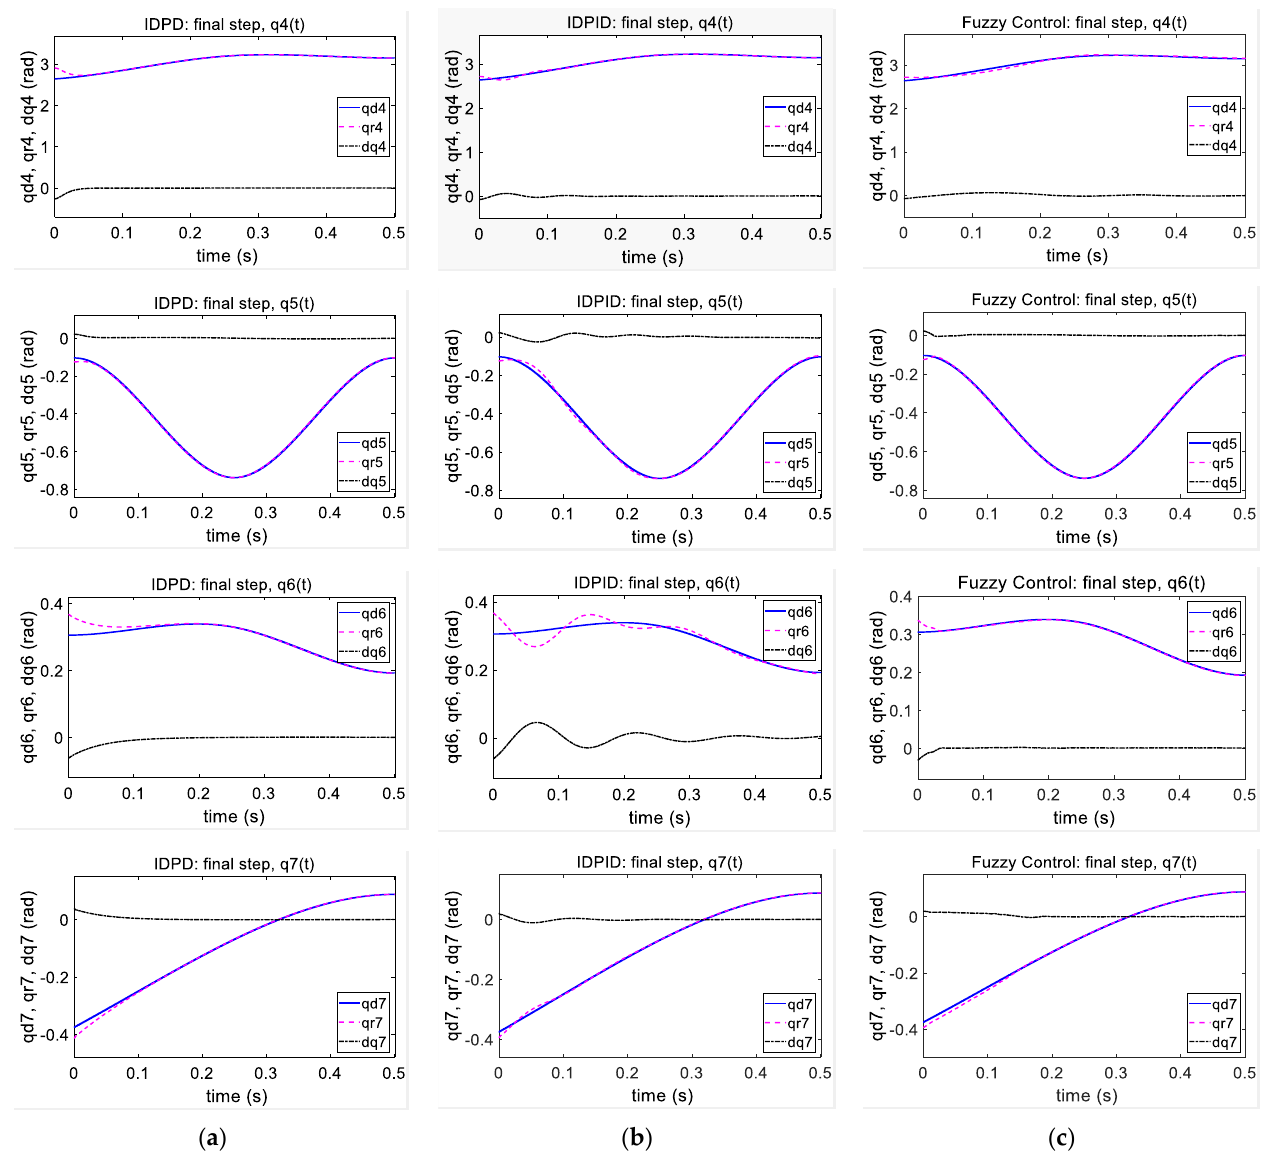
Figure 17. Simulation results of controllers for bipedal robots at the final step: ( a ) IDPD controller; ( b ) IDPID controller; ( c ) fuzzy controller.